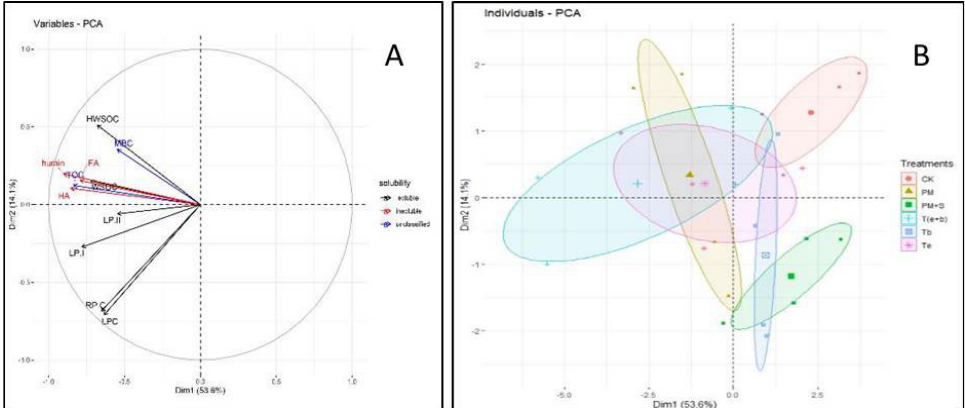
Figure 9. PCA loading values, CK—control; Pm—pig manure; S—slurry; e—earthworms; b—bacteria; T—Pm + S; Te—T + earthworms; Tb—T + bacteria; T(e + b)—T + earthworms + bacteria. PC2 is mainly related to the microbial biomass carbon content. ( A ) Corresponding scores ( B ) The total, labile, and recalcitrant OC data from the respective treatments after 5 years.